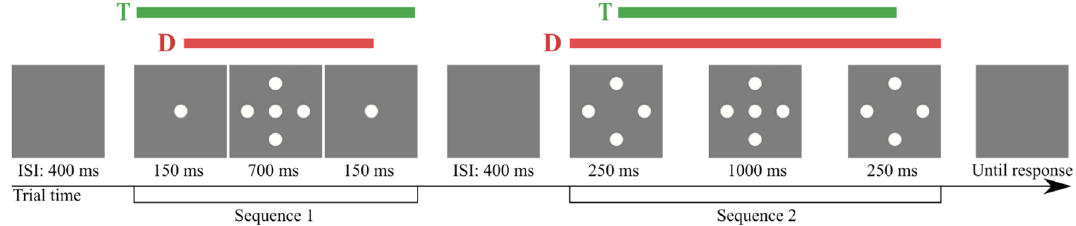
Figure 3. Example of experimental trial with 700 ms distractors (sequence 1) paired with 1500 ms distractors (sequence 2), each centred in time with 1000 ms In the Distractors condition, the sequences consisted of a central target and four surrounding blobs (distrac- tors). Participants were asked to compare the duration of the central targets exclusively and ignore surrounding ones. The duration of the central target was always 1000 ms for both sequences. In each sequence, the duration of all four distractors was homogeneous between targets of the same sequence, either 300 ms, 700 ms, 1500 ms or 3000 ms, but always different between the two sequences of a pair. Considering that target and distractors would always have different durations, the onsets and offsets were adjusted so that durations were centred. See Fig. 3 for an example. In the Ensemble condition, we used the same stimuli as in the Distractors condition, with the only dif- ference that the instructions were to compare the duration of the whole array of stimuli from each sequence, considering the target to start with the appearance of the first element and end with the disappearance of the last one, regardless of them being the central or surrounding elements. Hence, all stimuli were considered part of the target in this condition. Finally, in the Control condition, each sequence consisted of only one central blob (target). The target dura- tion in each sequence could be 300 ms, 700 ms and 1500 ms in any combination but always different between sequences of a pair. In each condition, all possible combinations of sequences were repeated up to 30 times per participant and divided into five blocks that included six repetitions of each combination in a randomised order. After each of the blocks, participants could take a short self-timed break. Each participant performed all three conditions of the task in a counterbalanced order.